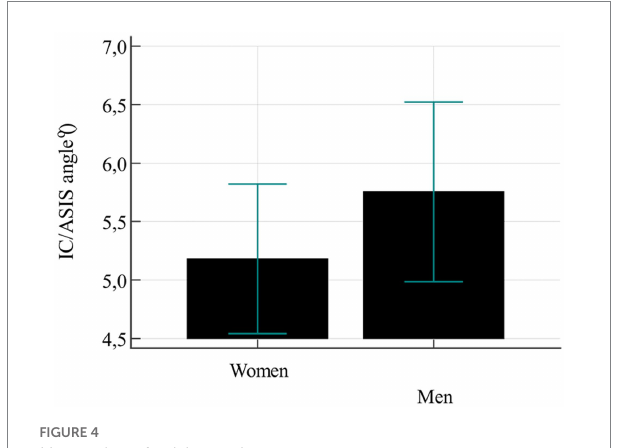
FIGURE 5 Mean pelvic obliquity